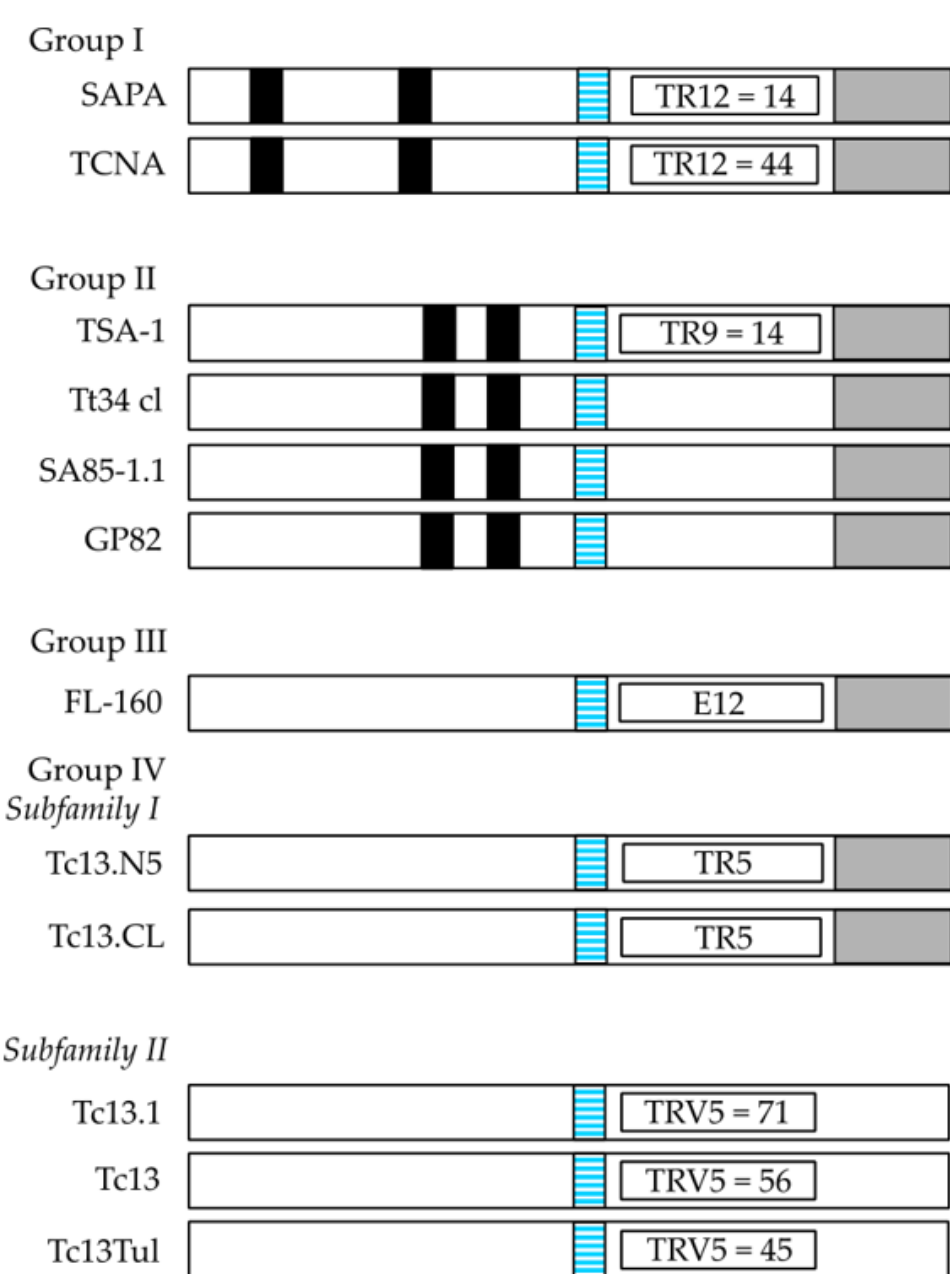
Figure 1. The Trans-sialidase (TS) superfamily. Schematic representation (not to scale) of the four groups of TSs from T. cruzi . Characteristic motifs for TS are SxDxGTW (black boxes), VTVxNVxLYNR (light blue boxes), and the GPI-anchor signal at the C-terminus is shown in grey. Tandem repeats (TR) containing 12 amino acid residues [DS 2 AH(S/G)TPSTP(A/V)] are shown inside an open box (TR12) and they are detected in SAPA and TCNA. In TSA-1, nine amino acid residue repeats (DK 2 ESESGDSE) are present (TR9, open box). This repeat is present 14 times in TSA-1. FL-160 possesses a characteristic epitope TPQRKT 2 EDRPQ (E12, open box). In subfamily I of Group IV, a pentapeptide (EPKSA) is found once (TR5, open box), whereas in subfamily II it is repeatedly found (TRV5, open box). In members of subfamily II of Group IV a GPI-anchor signal is